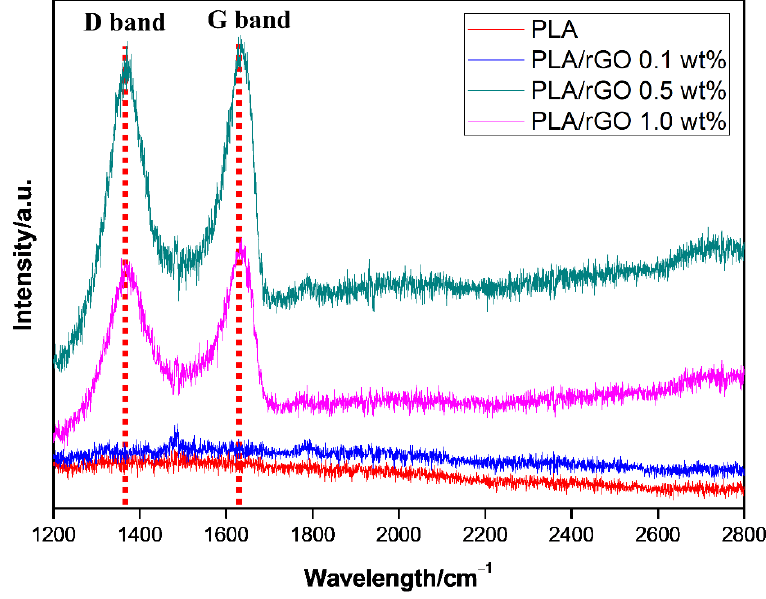
Figure 8. Raman spectra of PLA/rGO 0.5 wt% and PLA/rGO 1.0 wt%.